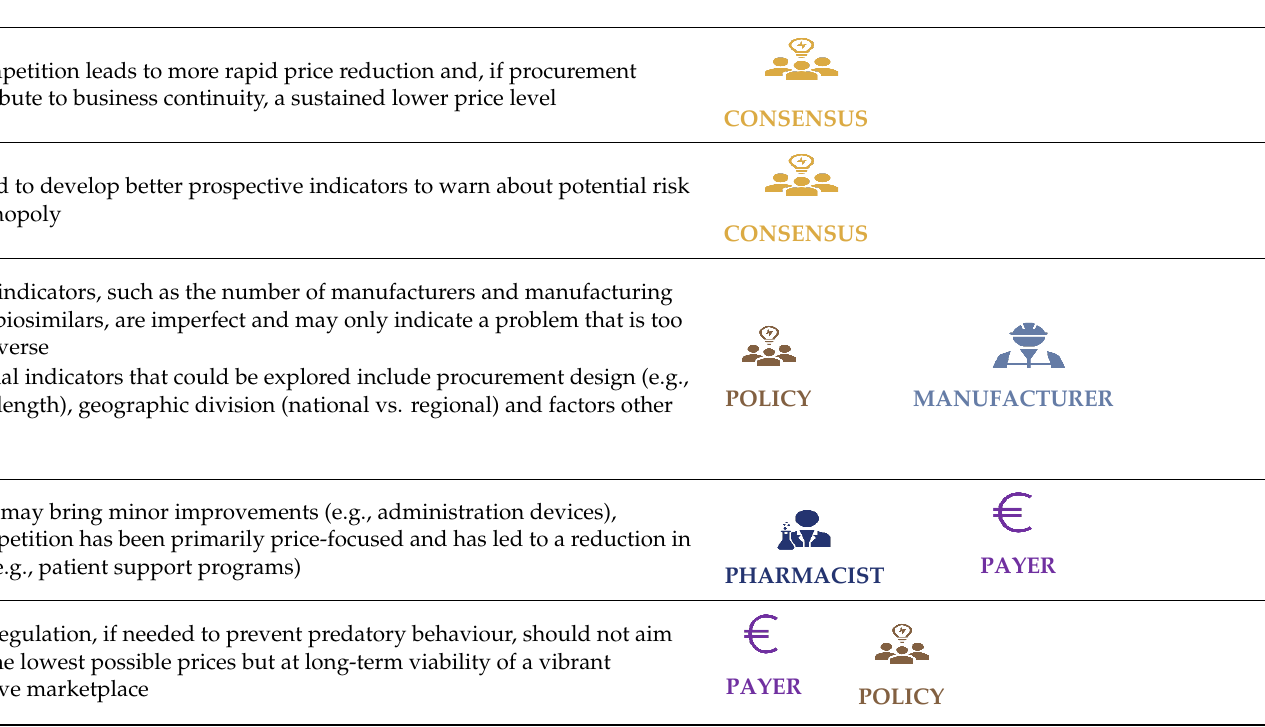
Table 1. Consensus on components of a sustainable biosimilar market. Table 2. Consensus on drivers and risks to biosimilar market sustainability (competition and incentives).